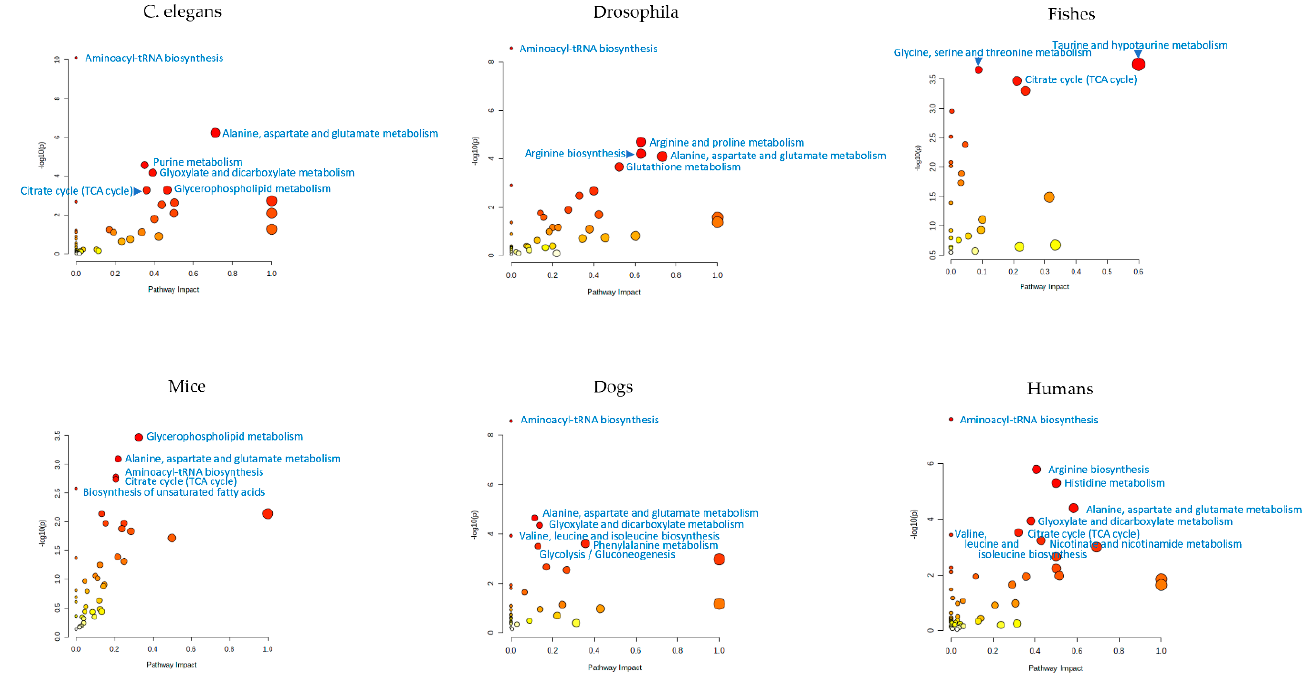
Figure 3. Metabolic pathways in animal and human models potentially involved in the aging processes. Graphs were generated by the metabolite set enrichment analysis (MSEA) using the MetaboAnalyst program (www.metaboanalyst.ca; accessed on 18 September 2022) (‘pathway analysis’ option) by projecting metabolites onto metabolic pathways. The lists of metabolites associated with aging, which are presented in the papers mentioned in this review, were used for projection. Names of metabolic pathways with statistically significant ( p < 0.01) enrichment with projected metabolites are shown. The p value evaluates whether a measured set of metabolites is represented in the pathway more than expected by chance within a given list of metabolites ( p values from the pathway enrichment analysis). Metabolic pathways of Homo sapiens (for the ‘Humans’ and ‘Dogs’ graphs), Mus musculus (for the ‘Mice’ graph), Danio rerio (zebrafish) (for the ‘Fishes’ graph), Drosophila melanogaster (fruit fly) (for the ‘Drosophila’ graph), Caenorhabditis elegans (for the ‘C. elegans’ graph) from the KEGG were used to project metabolites. Pathway impact values are from the pathway topology analysis.